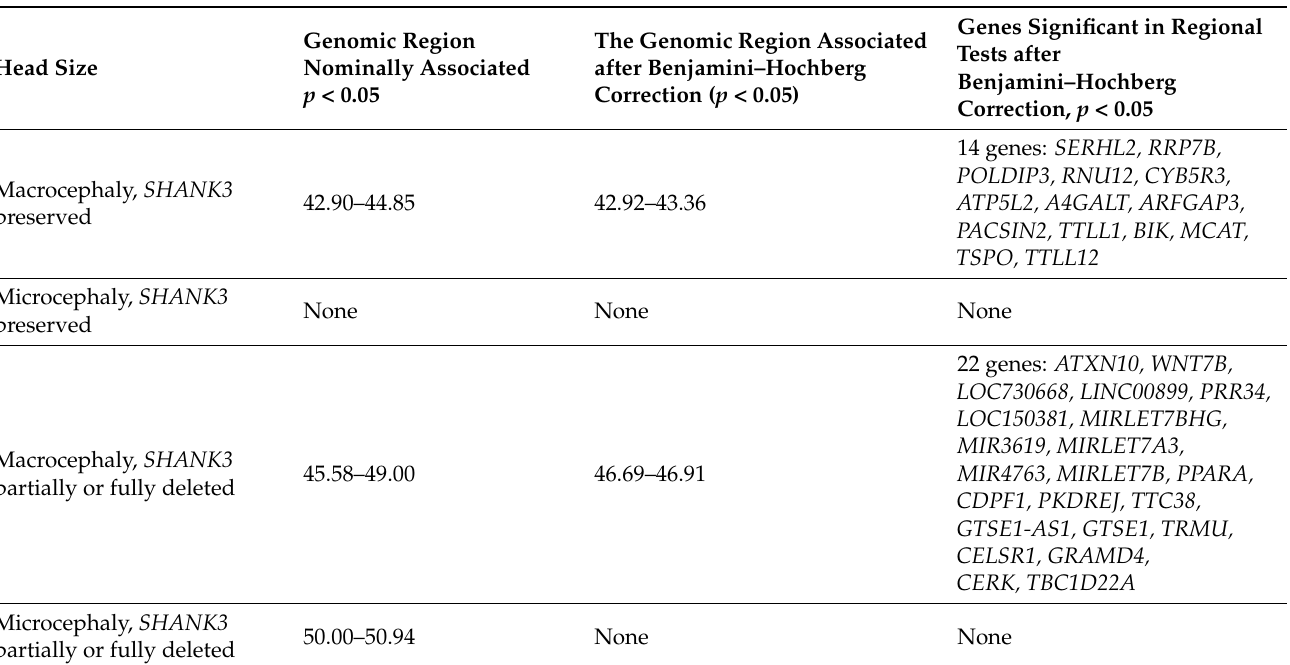
Table 5. Genomic regions (hg19) and genes that are associated with macrocephaly or microcephaly as compared to normocephaly. Corrected for multiple testing using the Benjamini–Hochberg method as implemented in Plink